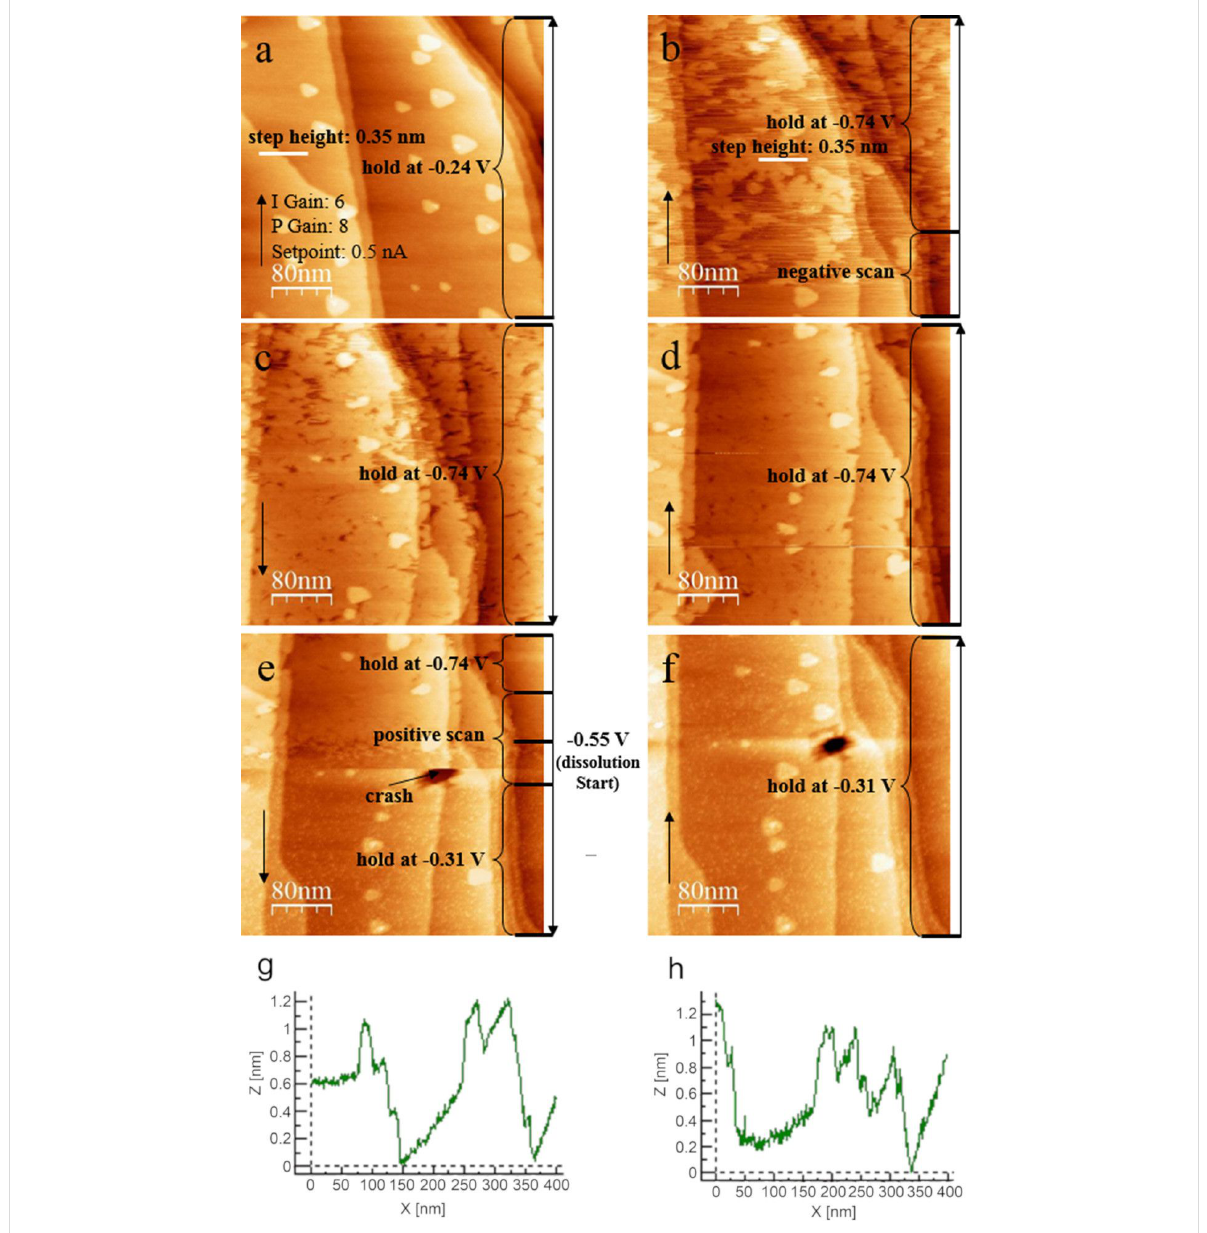
Figure 4: Sequential STM topographic images of Sb deposition/dissolution on Au(111) in 0.25 mM Sb 2 O 3 /0.5 M H 2 SO 4 electrolyte. (a) Initial Au(111) surface at open circuit potential of − 0.24 V. (b) The electrode potential was scanned from − 0.24 to − 0.74 V and then stopped at − 0.74 V, the height of Sb adlayer is shown with cross section in the image g. (c, d) The electrode potential was held at − 0.74 V, followed by formation of a complete mono- layer. (e) The electrode potential was scanned back from − 0.74 to − 0.31 V and then stopped at − 0.31 V, followed by dissolution of the monolayer. (f) The electrode potential was held at − 0.31 V. Line-by-line correction was applied for the topographic images. The two profiles (g, h) correspond to the two black lines in image a and f. Sample bias of 50 mV, set point = 0.5 nA and scan rate of 3.04 ln/s. Integral gain: 6, proportional gain: 8. Arrows indicate the scan